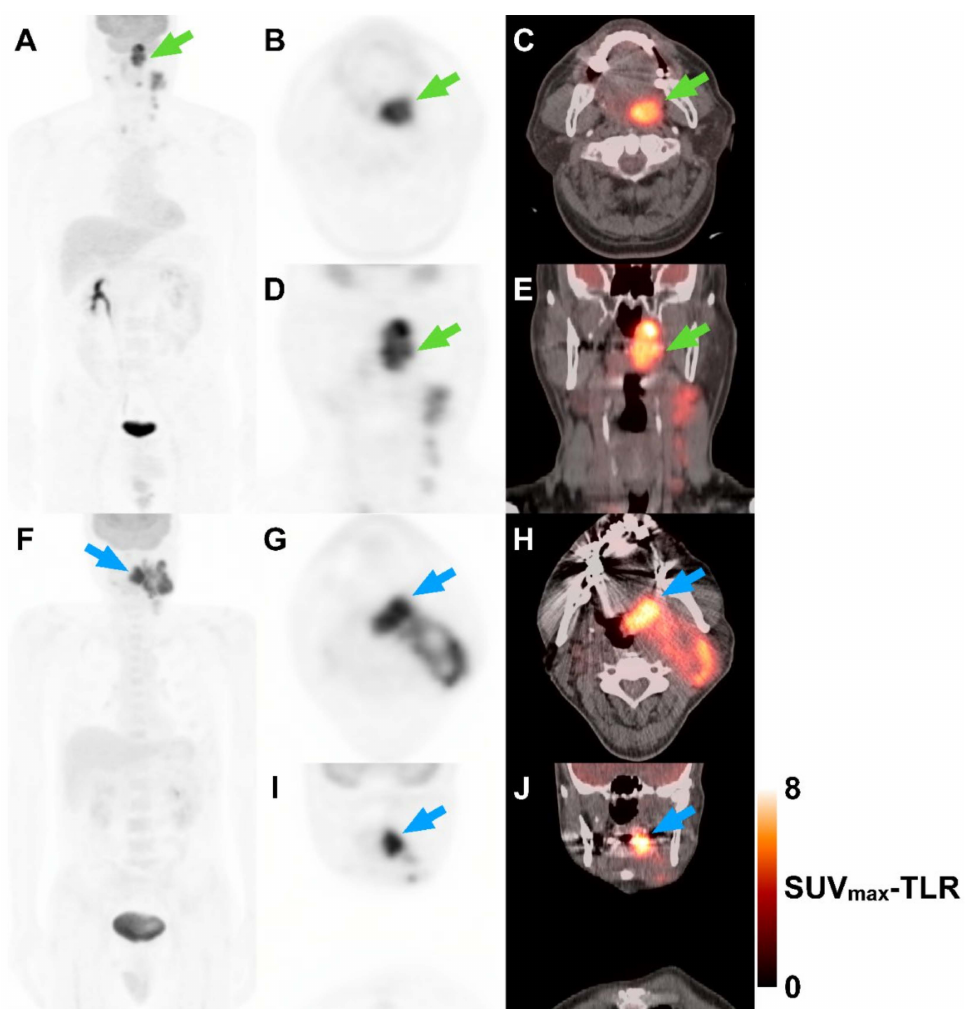
Figure 3. Two representative cases show that patients’ outcomes could be estimated based on metabolic parameters. A 59-year-old man with HPV-related oropharyngeal cancer squamous cell carcinoma (OPSCC) ( A – E ). Maximum intensity projection ( A ), axial and coronal PET ( B , D ), and fused PET/CT ( C , E ) images demonstrate left tonsillar mass with bilateral cervical lymph node metastasis. The primary tumor shows heterogeneous FDG uptake (green arrows). The TNM designation is T4N2M0 with a prognostic grouping of stage III. Tumor SUV max to liver SUV mean ratio (SUV max - TLR) and coefficient of variation (CV) are 8.0 and 34.5%, respectively. The patient progressed after 11.6 months and died after 28.8 months. Another 59-year-old man with HPV-related OPSCC ( F – J ). Maximum intensity projection ( F ), axial and coronal PET ( G , I ), and fused PET/CT ( H , J ) images reveal left tonsillar mass with bilateral cervical lymph node metastasis. The primary tumor shows relatively homogeneous FDG uptake (blue arrows). The TNM designation is T4N3M0 with a prognostic grouping of stage III. SUV max -TLR and CV are 7.0 and 27.9%, respectively. The patient has not progressed or died during the 63.8-month